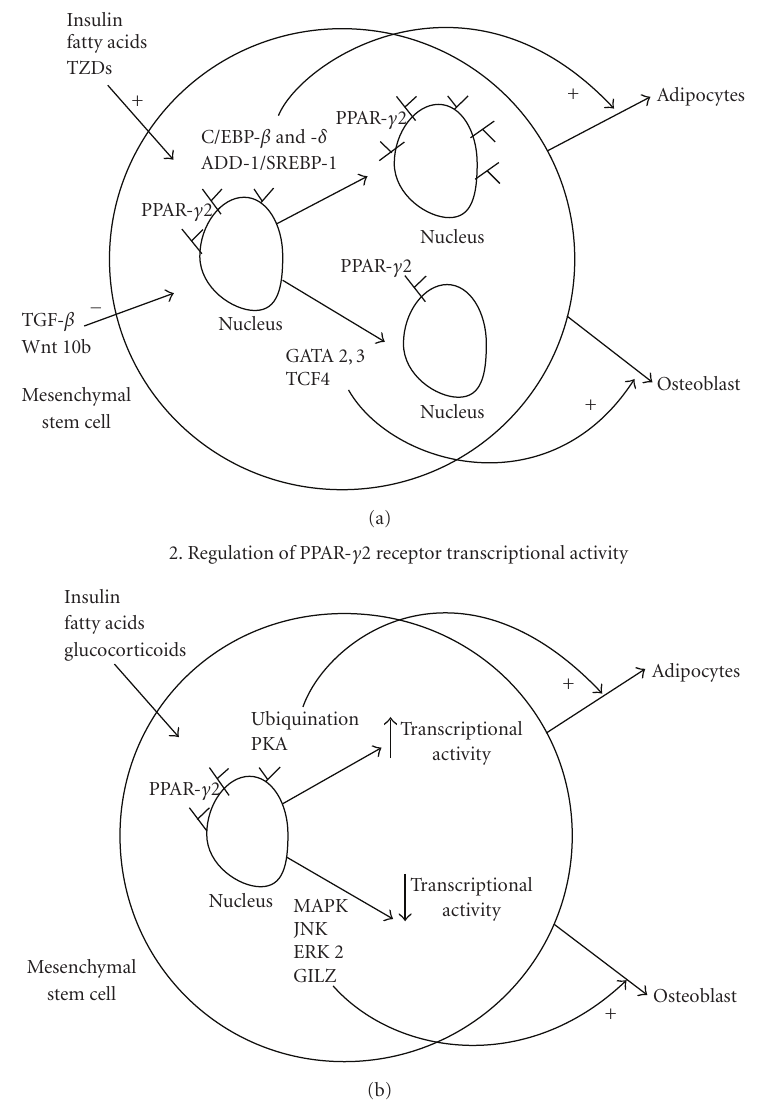
Figure 2: PPAR- γ 2 action is modulated by either changes in receptor expression or transcriptional activity . (a) Natural (insulin, long-chain fatty acids, or eicosanoids) or synthetic ligands (TZDs) to the PPAR- γ 2 receptor can either increase or decrease receptor expression resulting in in- creased adipocytic or increased osteoblastic di ff erentiation, respectively. (b) It is also possible to stimulate or inhibit PPAR- γ 2 transcriptional activity resulting in either increased adipocytic or osteoblastic di ff erentiation,